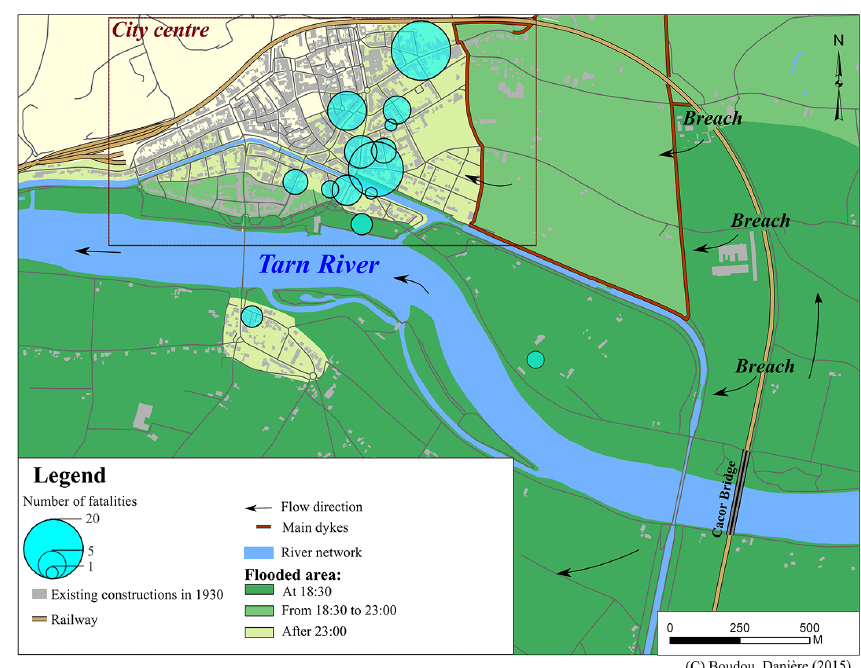
Figure 5. Flood chronology and location of fatalities during the flood event in Moissac on 3 March